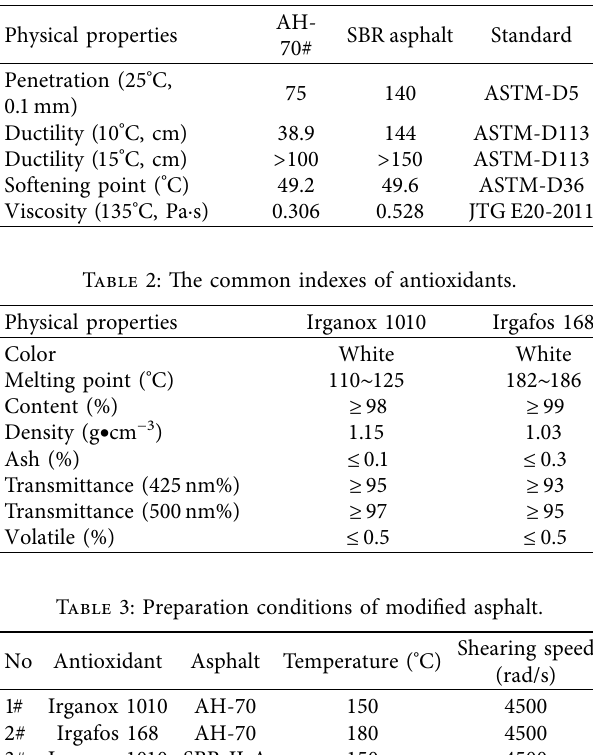
Table 1: Physical properties of the asphalt binder.